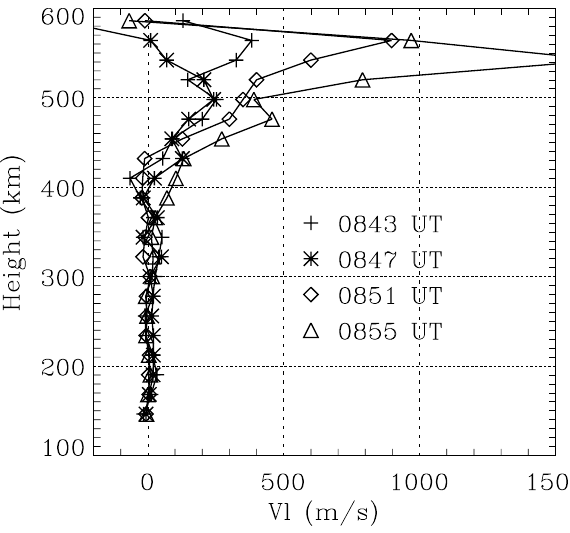
Fig. 1. The height profile of the field-aligned ion velocity at four consecutive times on 15 May 1997. Positive means upward.